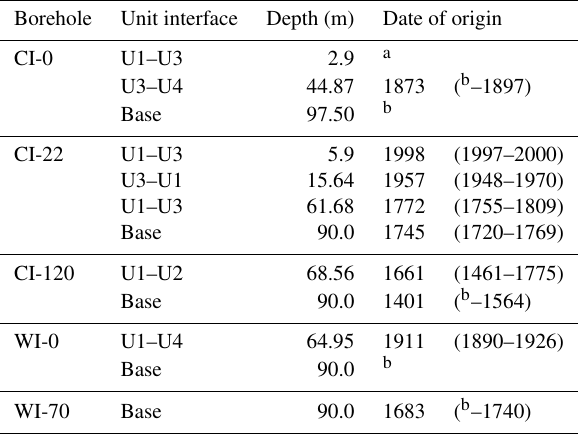
Table 1. Depths of the unit interfaces observed in borehole images (Ashmore et al., 2017), and age of surface origin based on the flow- line modelling. Ages in parentheses are the uncertainty ranges.